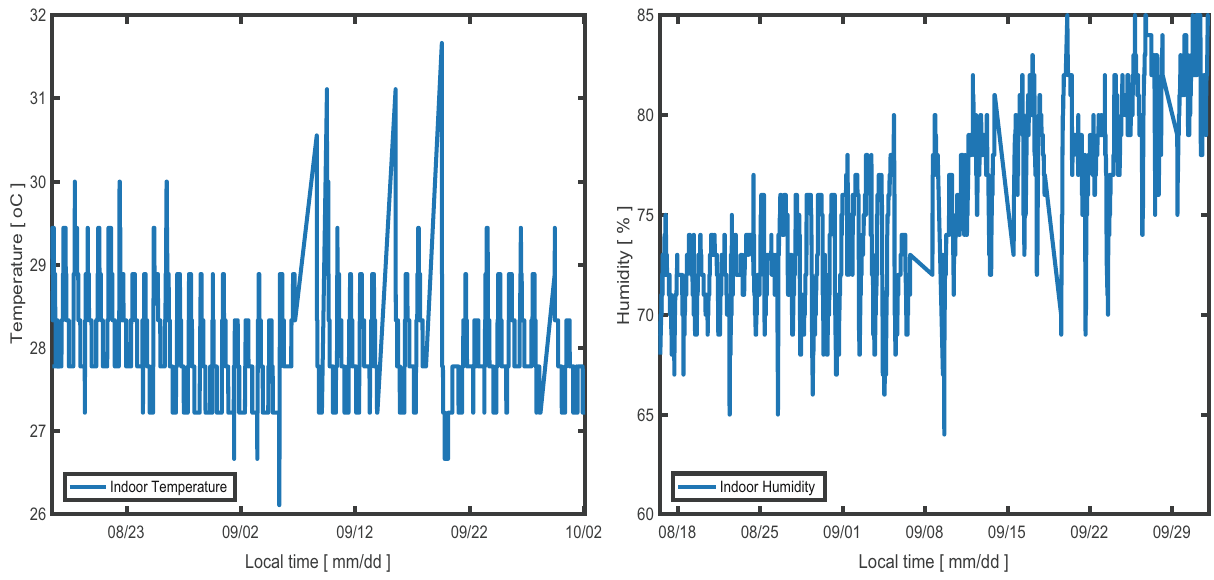
Figure 2: Indoor temperature and humidity during okra, Abelmoschus esculentus growth